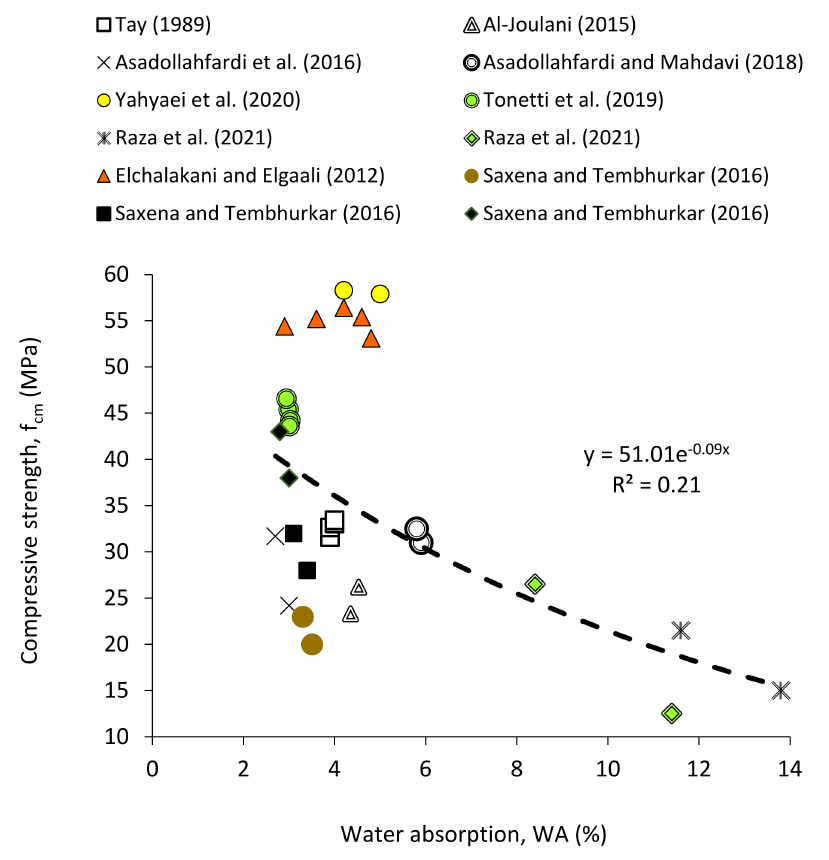
Figure 18. Relationship between compressive strength and water